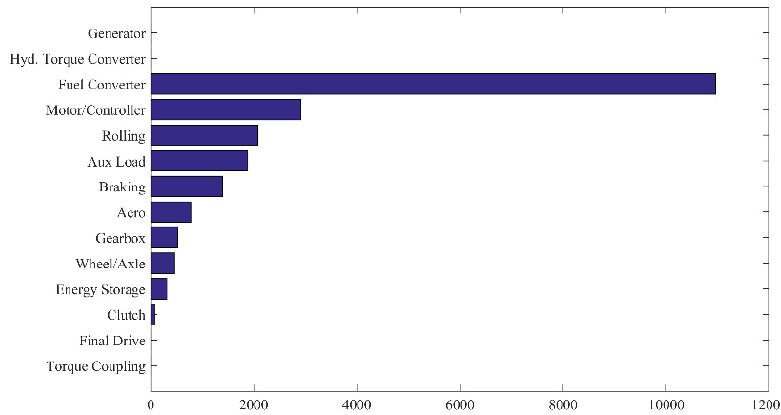
Figure 11. Energy usage (kJ) of HEV after optimization.